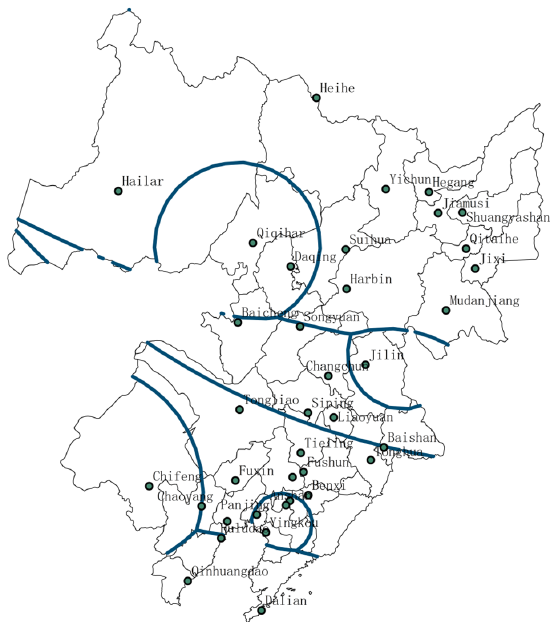
Figure 4. Attraction area of HRCCS Figure 2. Attraction area division based on